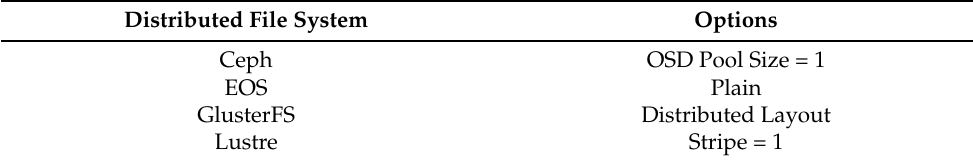
Table 5. Distributed layout.